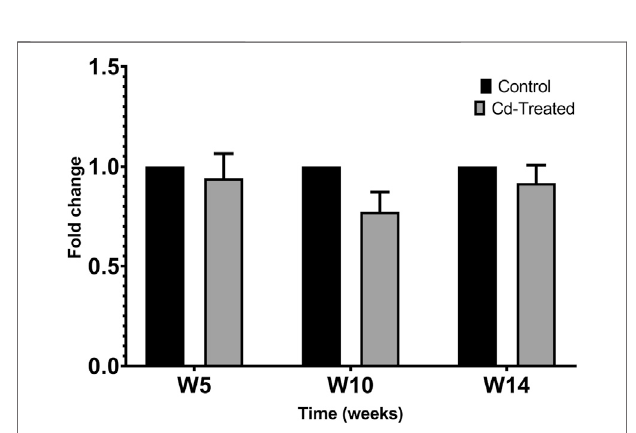
FIGURE 4 | Gelatinolytic activity of pro-MMP-2 after 24 h. Data is expressed as mean ± S.E.M of fold-changes compared to the control ( n (cid:2) 8).